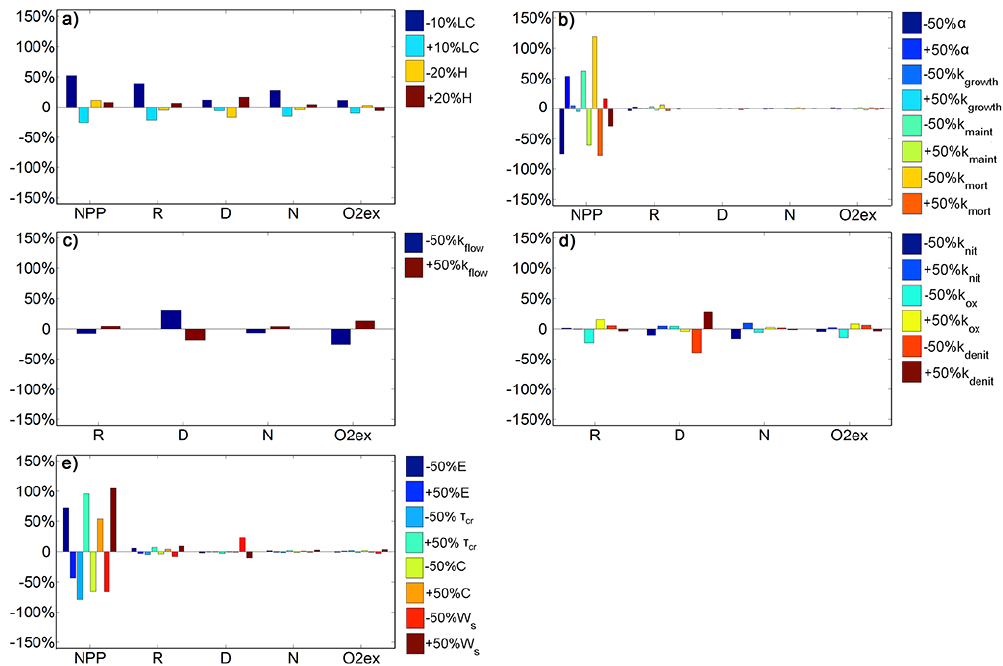
Figure 13. Results of sensitivity tests for variations in (a) geometrical parameters, (b) primary production parameters, (c) O 2 air exchange rate, (d) biogeochemical rate constants and (e) sediment parameters, expressed in percent of the biogeochemical baseline budget values (see Fig. 12).